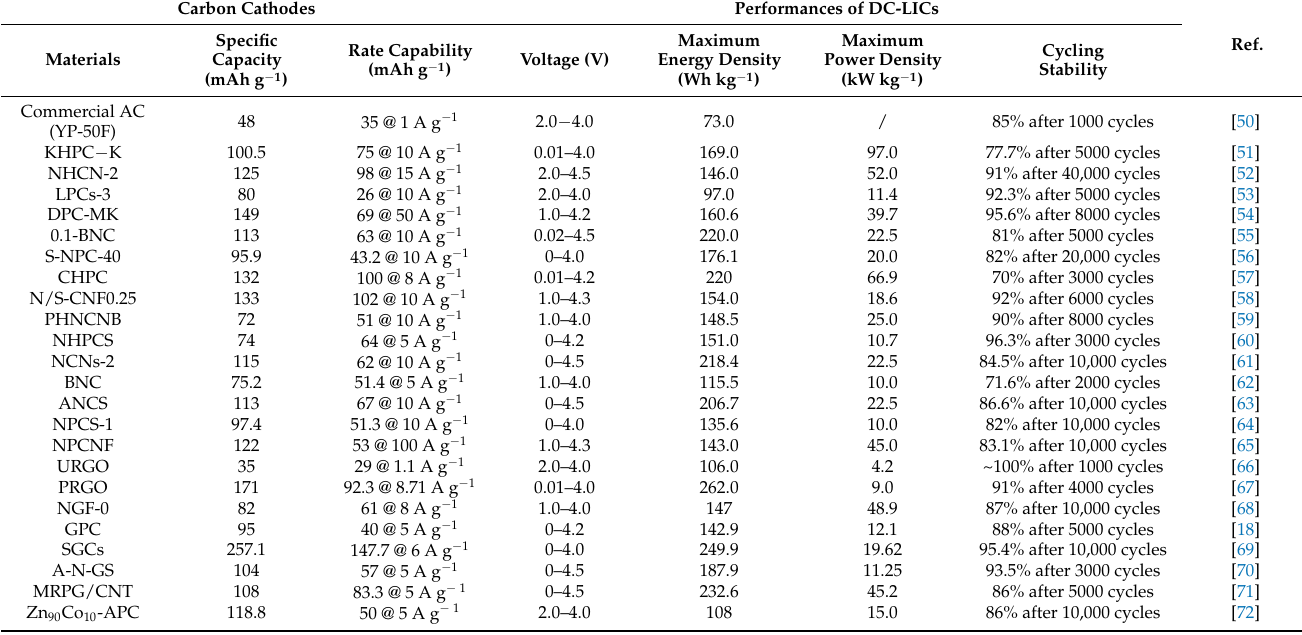
Table 1. Typical carbon cathodes and the electrochemical performances of DC-LICs.